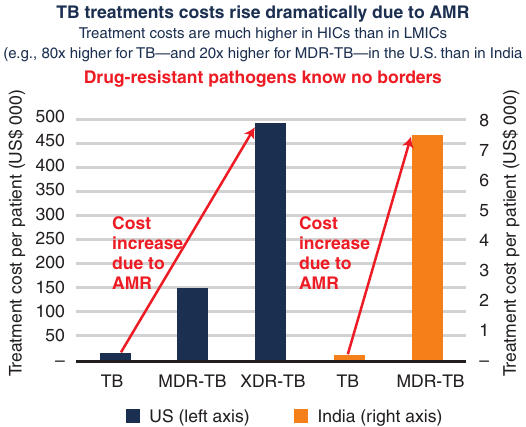
FIGURE 1. AMR Makes TB Far Costlier to